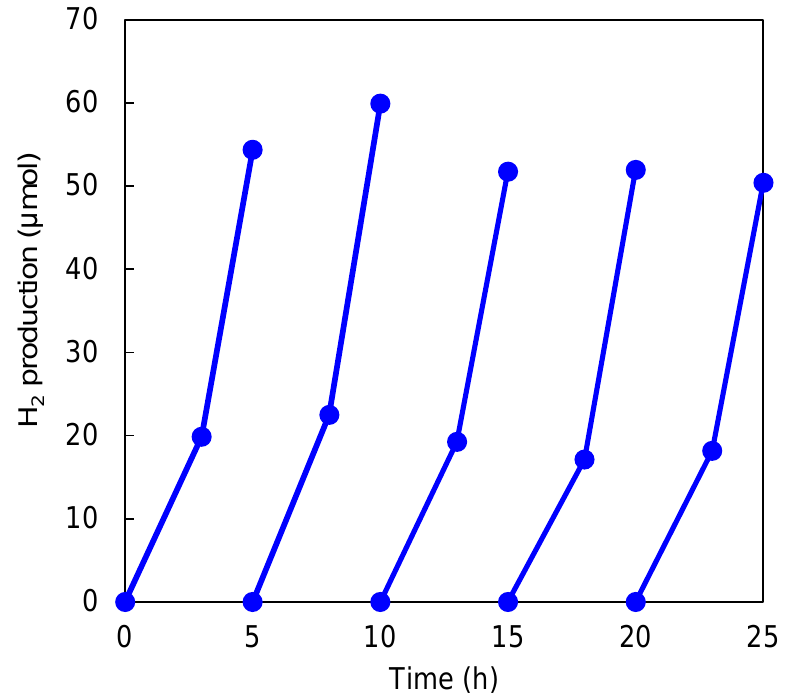
Figure 7. Cycled performance of photocatalytic H 2 production from formic acid with TiO 2 nanotubes with the aid of simultaneous Rh deposition. Reaction temperature: 50 °C; calcination temperature: 500 °C; calcination time: 10 h.